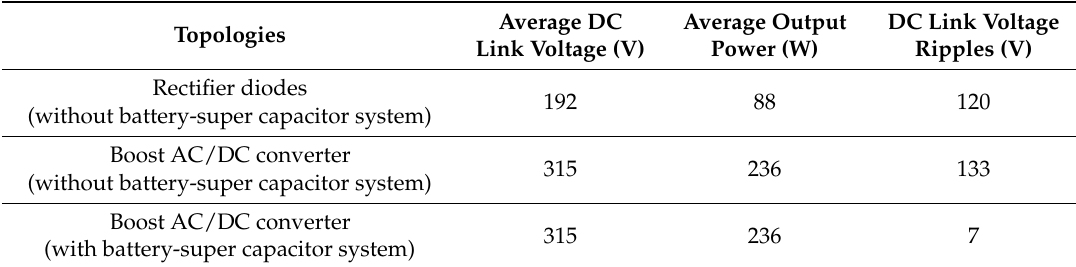
Table 2. Comparing performances of various system topologies.